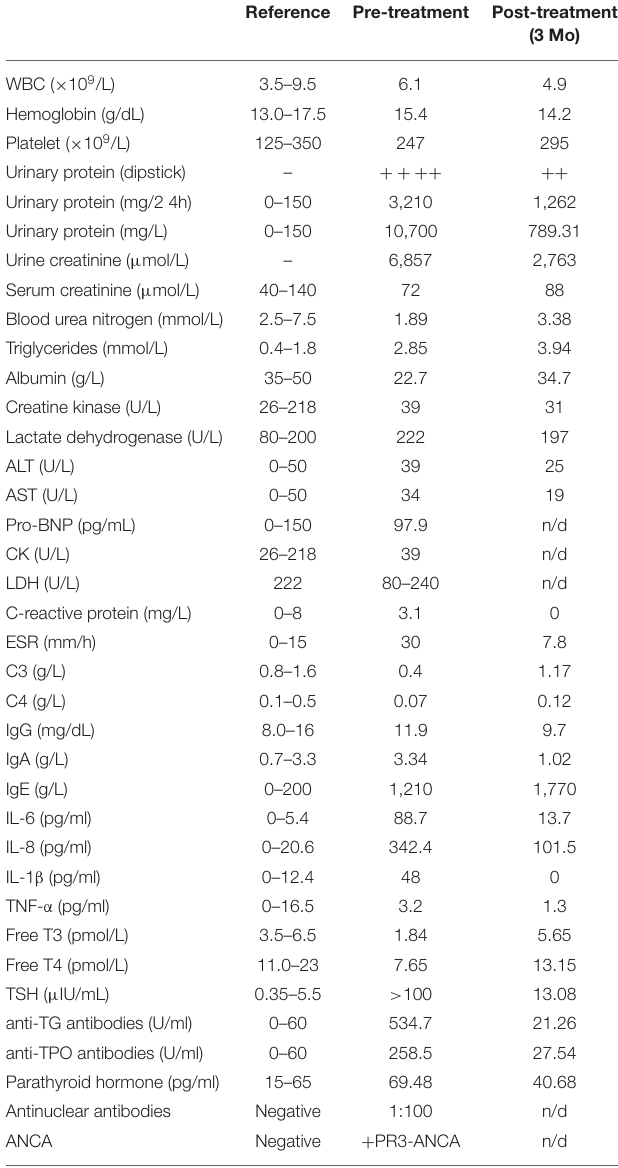
TABLE 1 | Laboratory data before and after